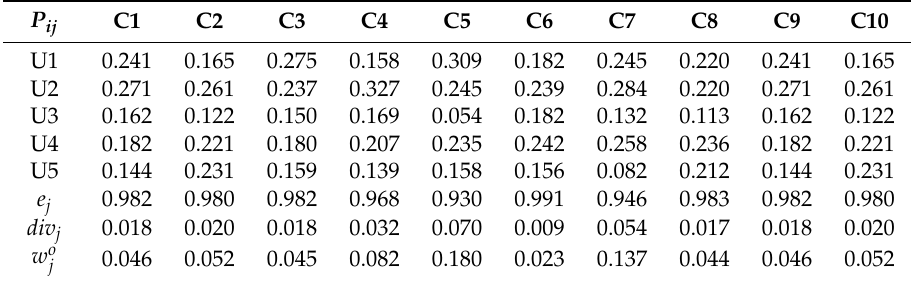
Table 16. P ij and evaluation criteria objective weights according to entropy method.